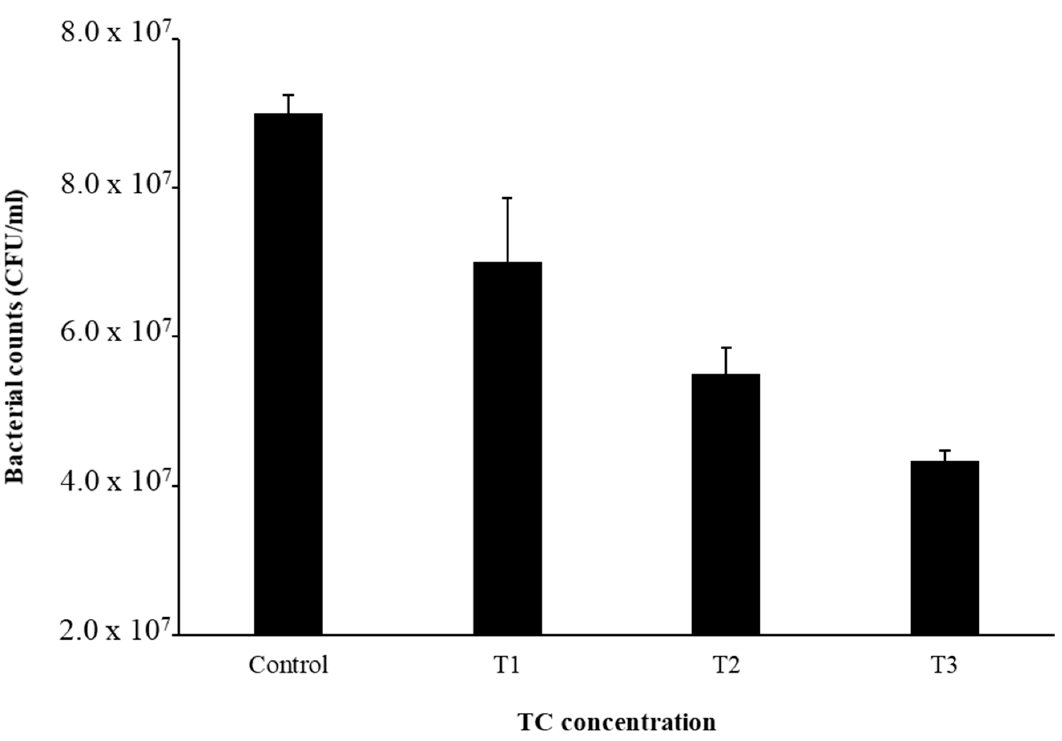
Figure 3. Bacterial cell counts after TC treatment. Experiments were performed in triplicate to calculate the mean and standard deviation.